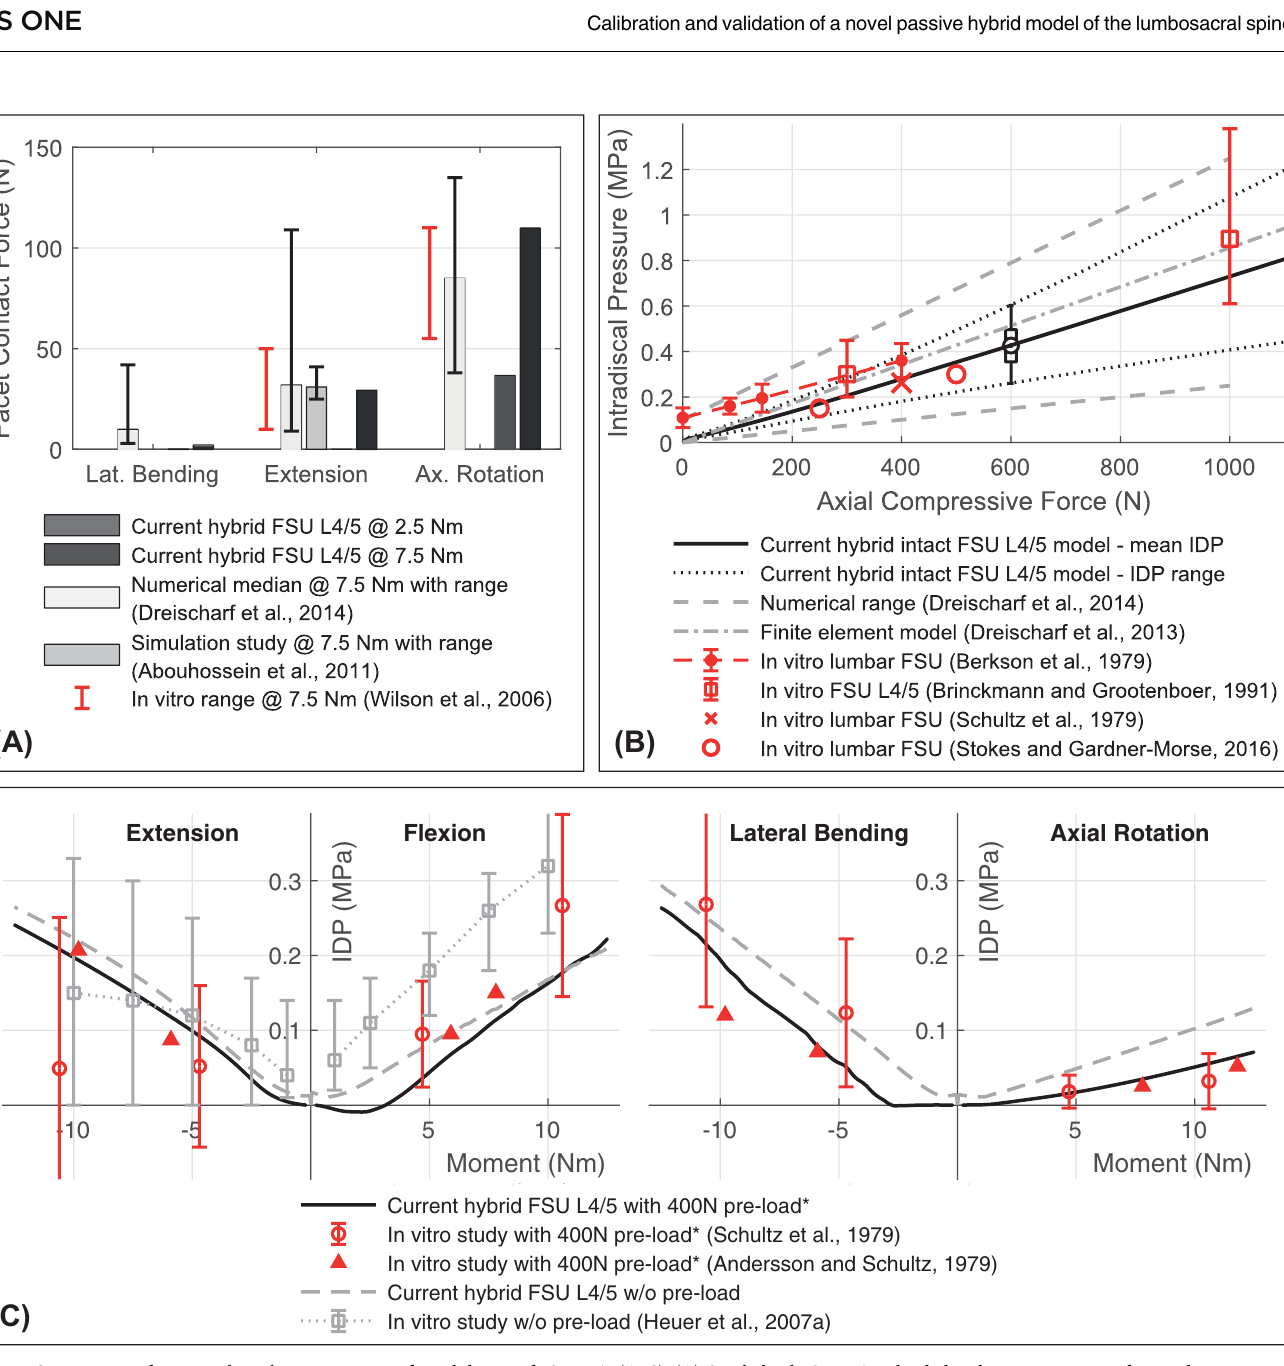
Fig 7. Comparison of structural mechanics responses for validation of FSU L4/5 (A-C). (A) Our hybrid FSU L4/5 is loaded with pure moments of 2.5 and 7.5 Nm. The predicted facet contact forces (3rd and 4th bar) are compared to in vitro measurements (red ranges) [139] and numerical values from literature [39, 97]. The reported numerical ranges represent minimal and maximal forces of all lumbar levels in eight models (1st bar) and ligament stiffness variations (2nd bar). (B) The predicted intradiscal pressure of our FSU L4/5 versus an axial compression force is compared to experimental in vitro data [124, 125, 137, 138] and values from published numerical models [97, 142]. The numerical range refers to the predictions by eight validated finite element models [97]. Since our IDP is calculated by averaging all nodal pressures in the NP [71], the resulting mean IDP (solid black line) and the scatter of individual pressure values (dotted lines) are shown. An exemplary pressure distribution is visualized as a box plot at 600 N. (C) The predicted IDP of our intact FSU L4/5 at eight loading conditions are compared to experimental in vitro data [123, 129, 137]. � The increasing IDP superimposed with 400 N pre-load are shown minus the initial mean compression-induced pressures. Subtracted initial IDP are 0.273 MPa for the current hybrid FSU L4/5 (solid black line) and 0.262 and 0.340 MPa, respectively, for the in vitro data [137] and